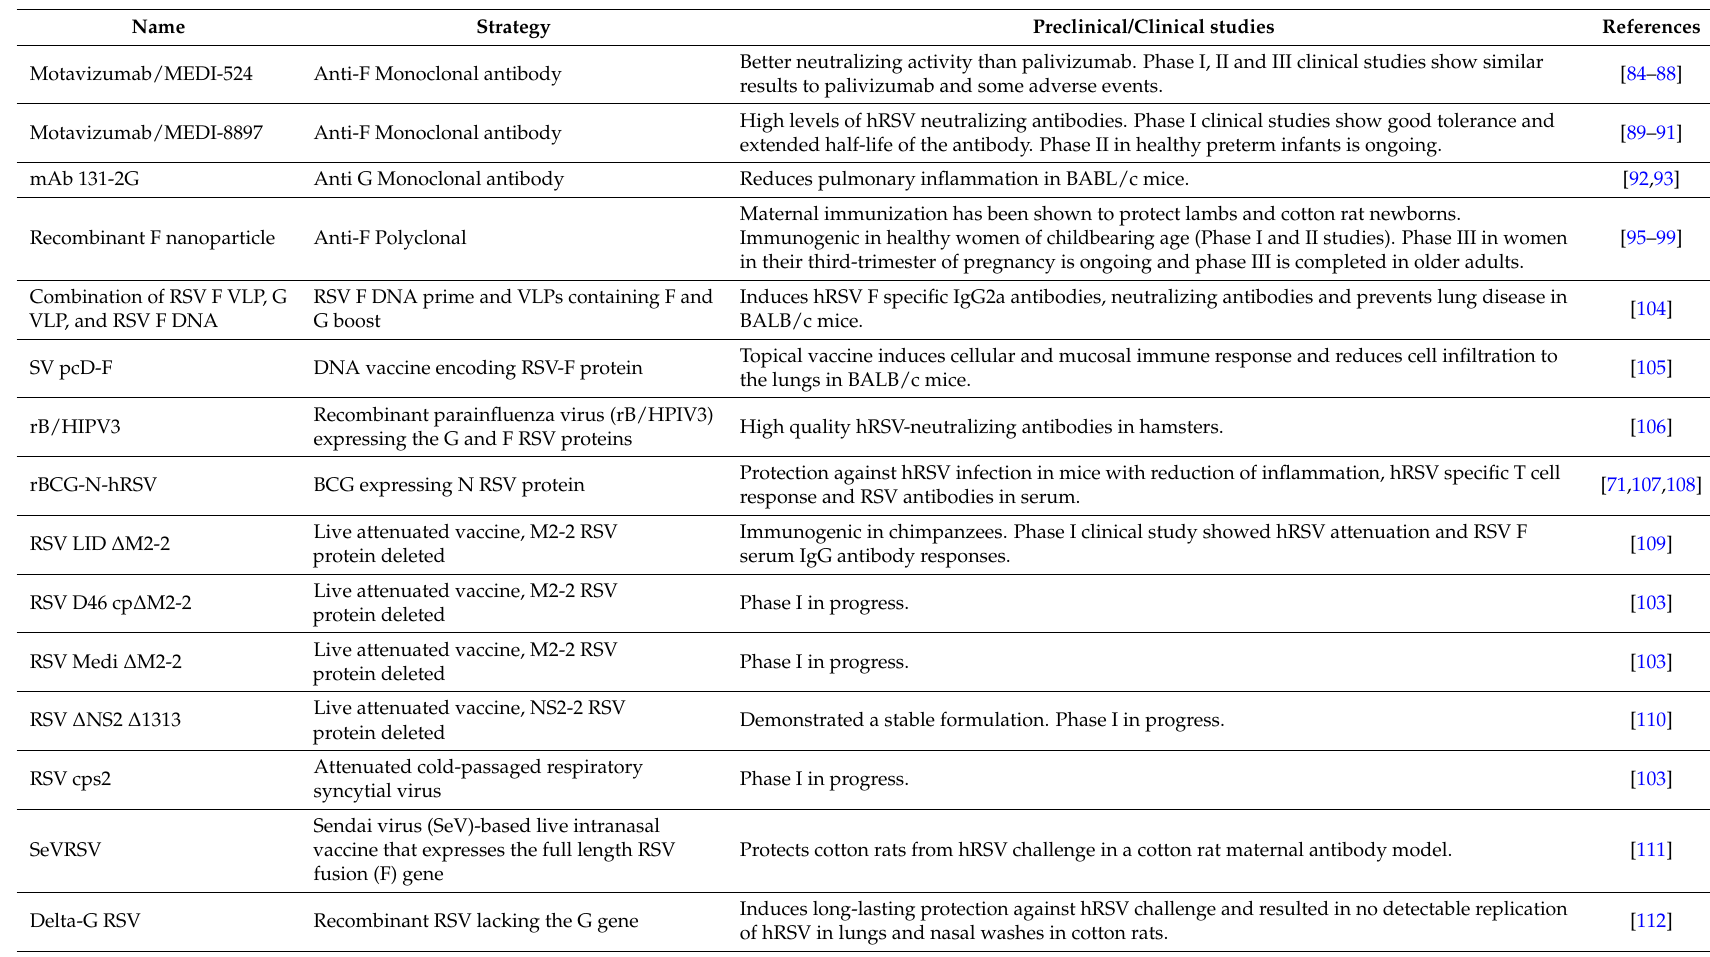
Table 1. Current research on therapies and vaccines against hRSV